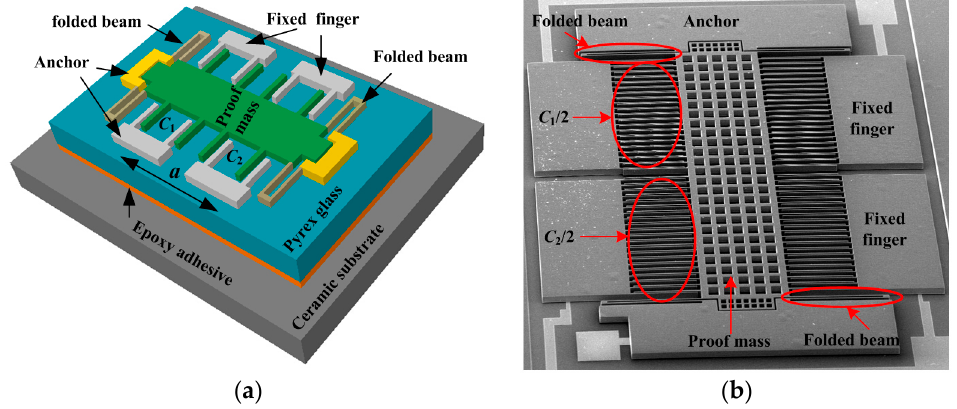
Figure 1. Structure of capacitive accelerometer. ( a ) Diagram of accelerometer; ( b ) SEM structure.